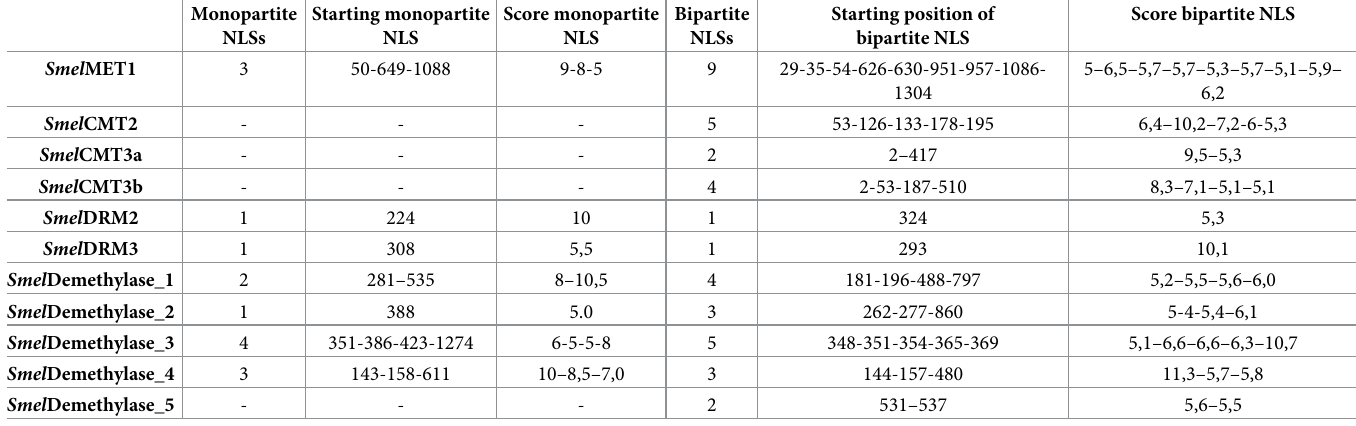
other groups the CMT1/CMT3 proteins (containing Smel CMT3a and Smel CMT3b). The Table 2. The mono- and bipartite nuclear localization signals (NLSs) (cut-off score = 5) identification in eggplant C5-MTases and demethylases. Score higher than 8 indicates an exclusive protein localization in the nucleus. Monopartite